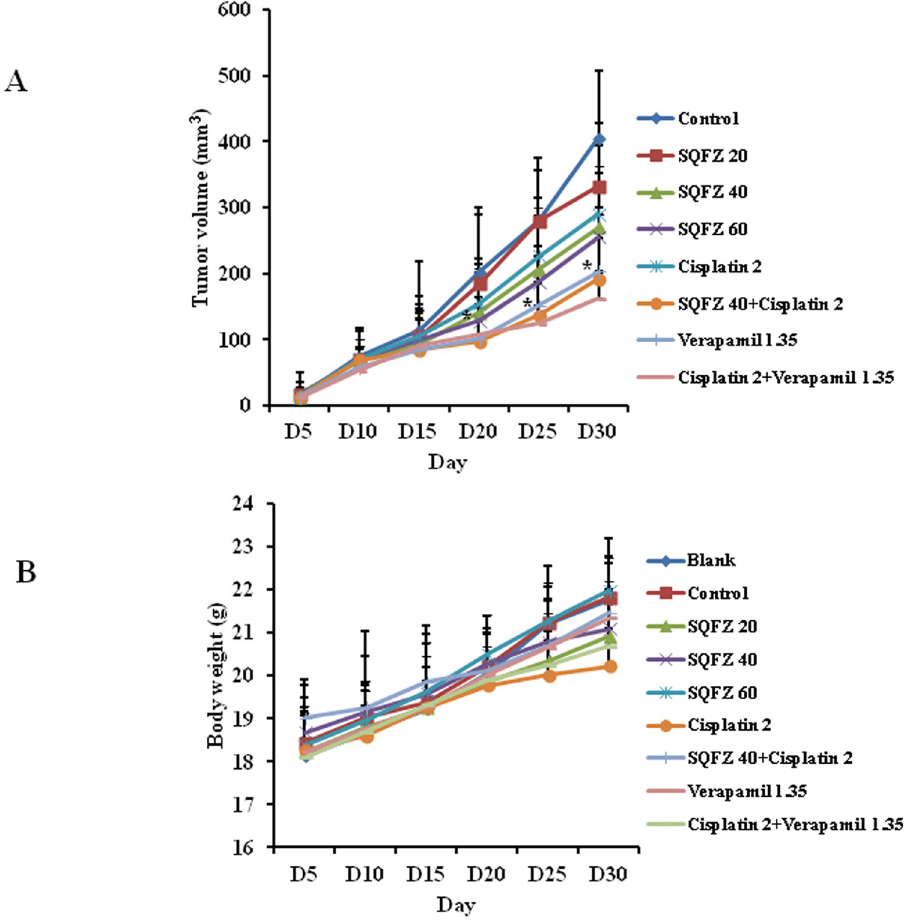
Fig 1. Effects of SQFZ or SQFZ + cisplatin on tumour growth in MDA-MB-231/DDP+M2 xenografts. BALB/c nude mice bearing MDA-MB-231/DDP+M2 in fat pads as xenografts were treated daily with i.p. injections of control or SQFZ 20, 40, 60 mL/kg, Cisplatin 2 mg/kg, SQFZ 40 mL/kg + Cisplatin, Verapamil 1.35 mg/kg, or Verapamil + Cisplatin for 4 weeks. Tumour volumes (A) and mouse body weights (B) were measured as described. Data are presented as the means ± SD (n = 10). � P < 0.05 compared with Cisplatin